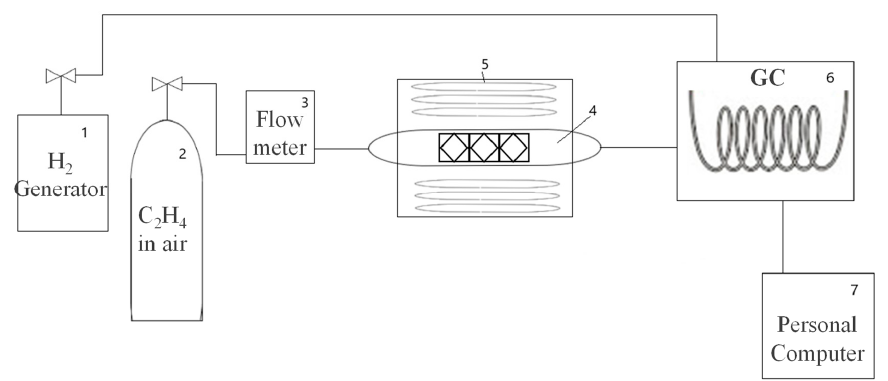
Figure 10. The scheme of the second photocatalytic system: 1—hydrogen generator, 2—model ethylene gas in the synthetic air (50 ppm), 3—flow meter, 4—quartz tube, 5—Semilac UV LED lamps, 6—gas chromatograph, 7—personal computer.